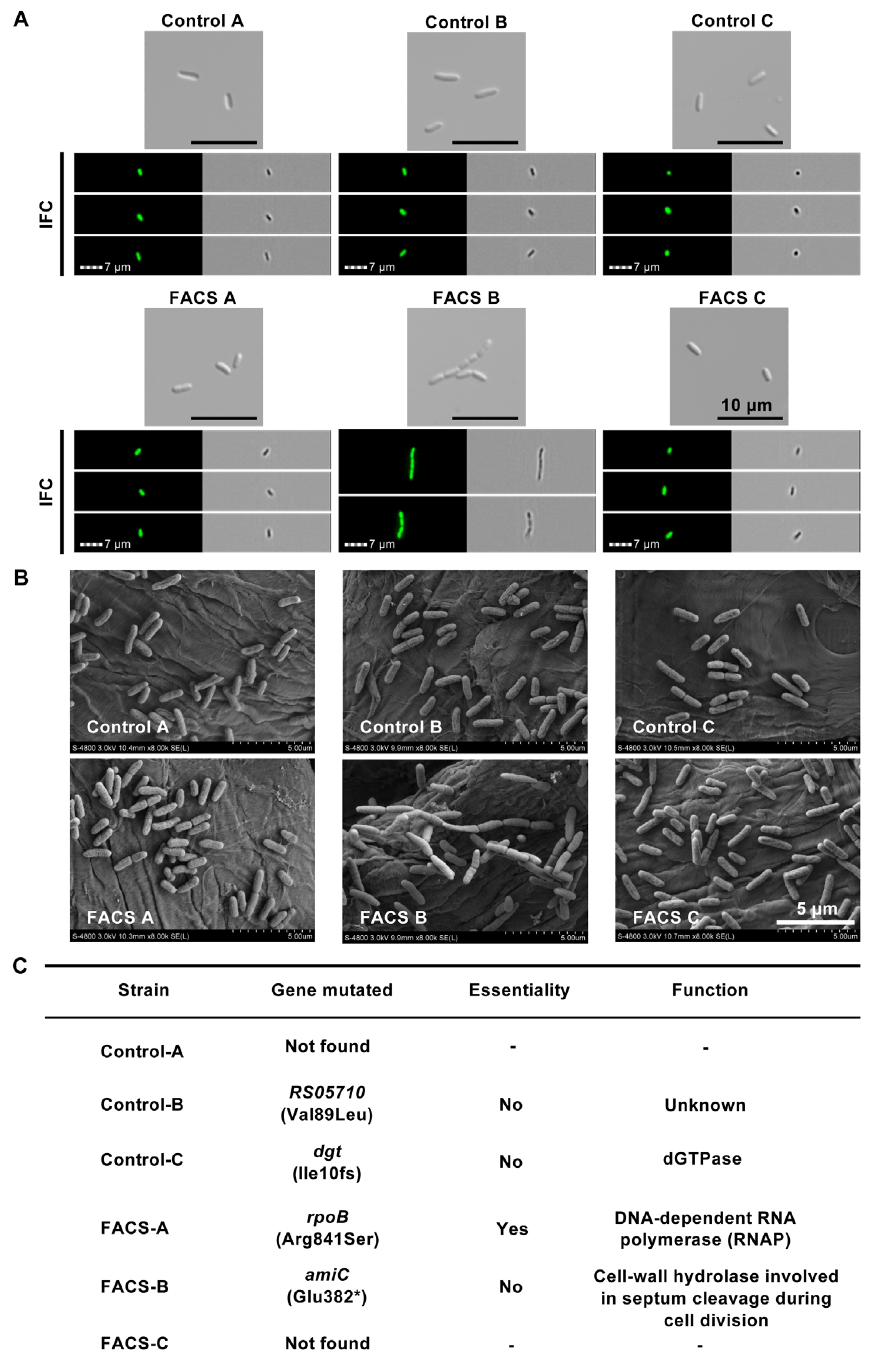
Figure 3. The changes in morphology and genomics through continuous cell sorting and